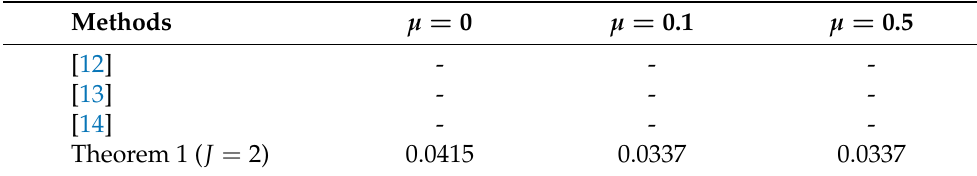
Table 2. Delay bound h ∗ calculated for Example 2.